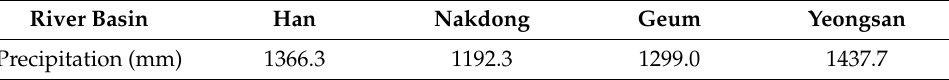
Figure 1. Study area and six reservoirs: ( a ) locations of four major River basins (Han, Nakdong, Geum, and Yeongsan) in South Korea. The red box highlights the Nakdong River Basin; ( b ) locations of six reservoirs and watersheds (indicated by diagonal lines). In this study, we consider Andong reservoir and Imha reservoir as a single reservoir as they are connected through a channel and operated together. Table 1. Average annual precipitation of four major river basins in South Korea [34]. The Nakdong River Basin has the least amount of annual precipitation among four major river basins.